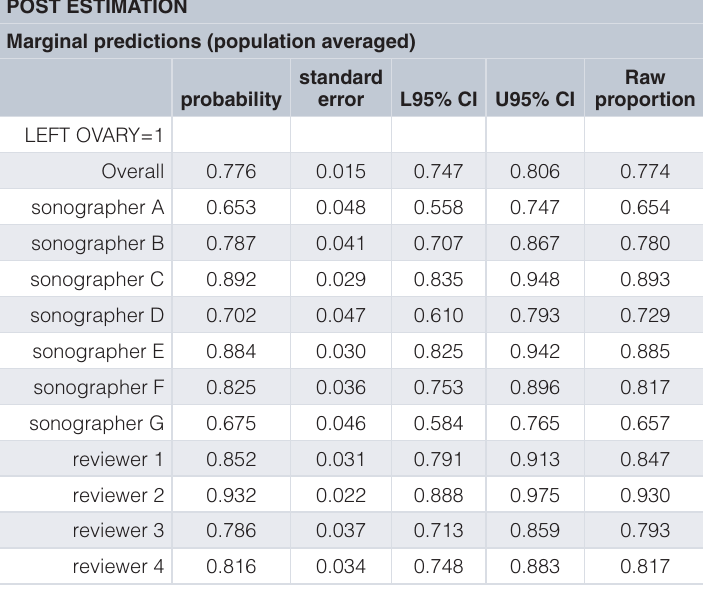
Table 2. Results of the random effects bivariate probit model – marginal